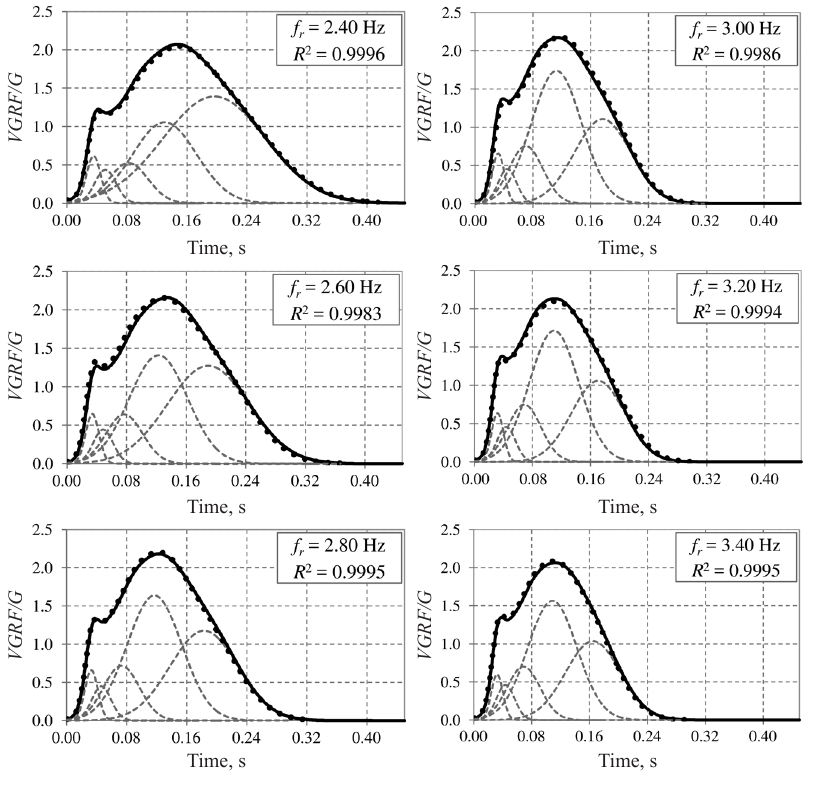
Figure 15. Comparisons of the VGRF / G templates before and after interpolation of parameters of the Gaussian function in frequency range f r = 2.4–3.4 Hz: black dotted line – the VGRF / G templates before interpolation of parameters of the Gaussian function; solid black line – the VGRF / G templates after interpolation of parameters of the Gaussian function, grey dashed line – the Gaussian curves (five components of Eq.